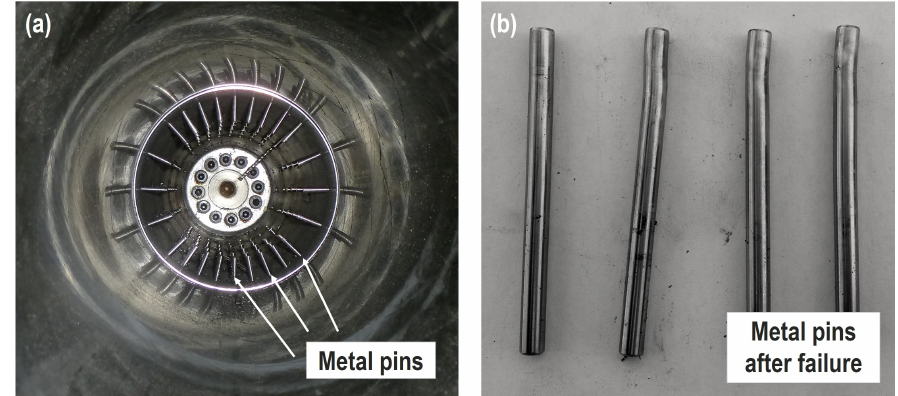
Figure 8. ( a ) View in the rudder stock showing the distribution of metal pins (higher pin density in vertical direction); ( b ) deformed metal pins after